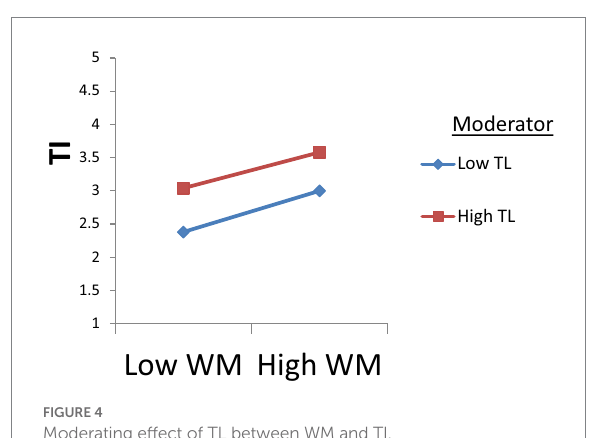
transformational leadership. The interaction term of transformational leadership on the above graph shows that